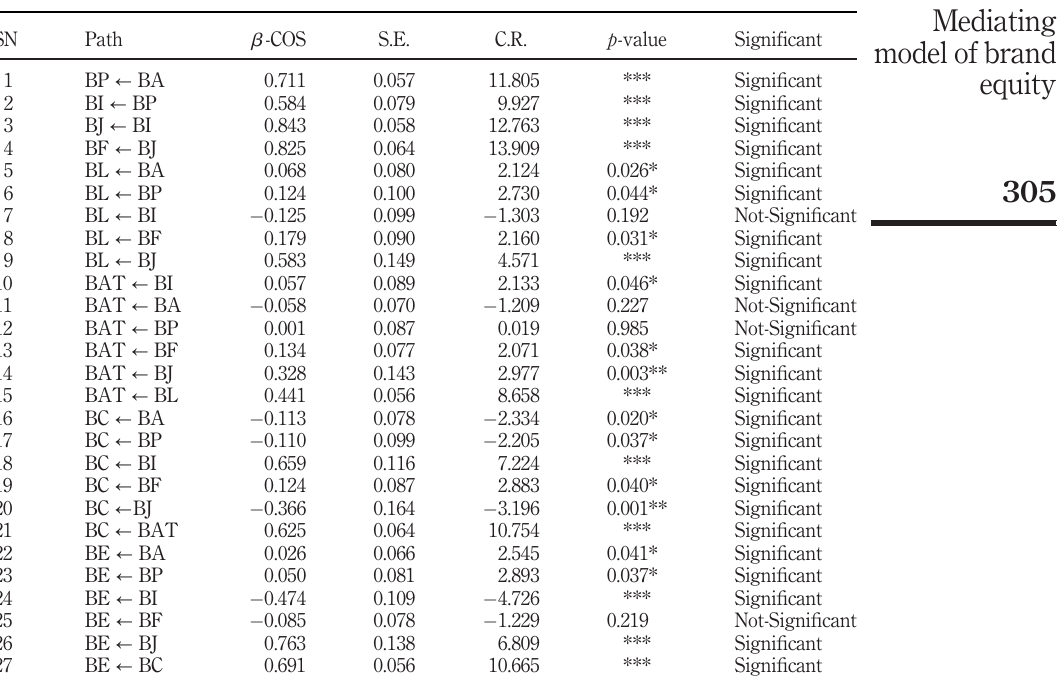
Table II. Existing model of Brand equity